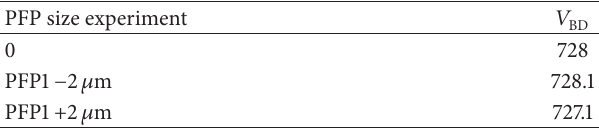
Table 2: 𝑉 of different PFP1 BD